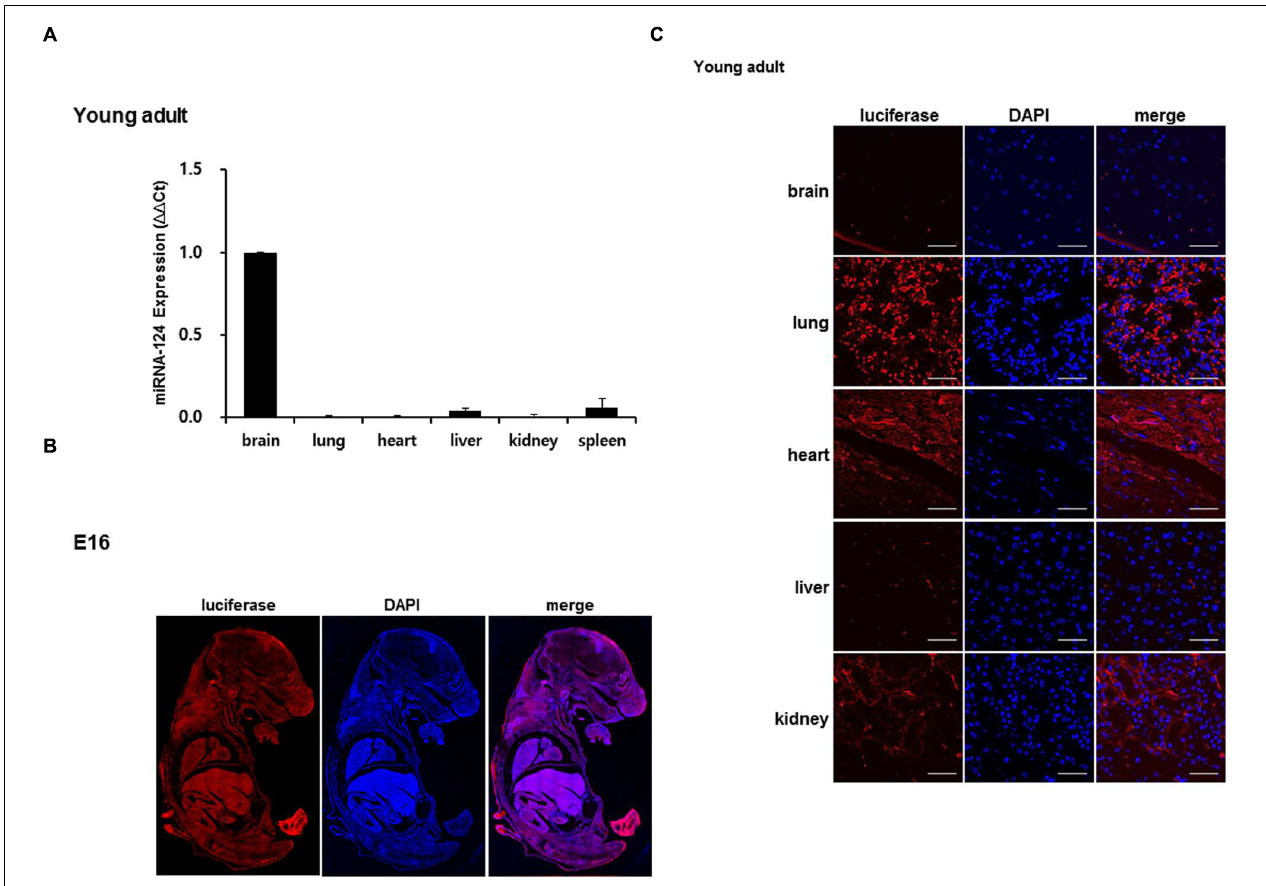
FIGURE 3 | Validation of luciferase expression of a miR-124 reporter transgenic mouse. (A) In a young adult mouse, quantitative RT-PCR of tissue RNAs of brain and major organs revealed prominent expression of miR-124 normalized to that of U6. The expression of other organs was represented using a fold increase relative to the value 1 of the brain [means ± SD ( n = 3)]. (B) At E16 period of a transgenic mouse, luciferase transgene expressed as shown and counterstained by DAPI on whole body immunohistochemistry (C) . Tissue sections of major organs of a transgenic mouse showed distribution of cells counterstained with DAPI (blue) and propensity of luciferase staining (red). Compared with highest lung and moderate heart/kidney activities, luciferase of brain and liver was scarce on confocal microscopy at 400 × magnification. The scale bars represent 50 µ